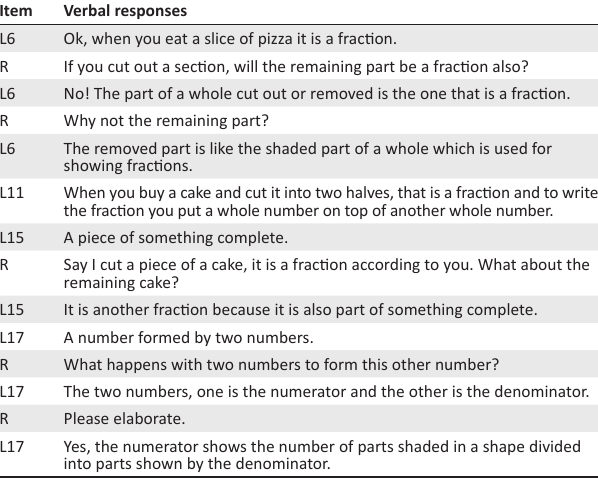
Table 6 contains verbatim responses of L6, L11 and L38 on the questions and prompts of the researcher (R)